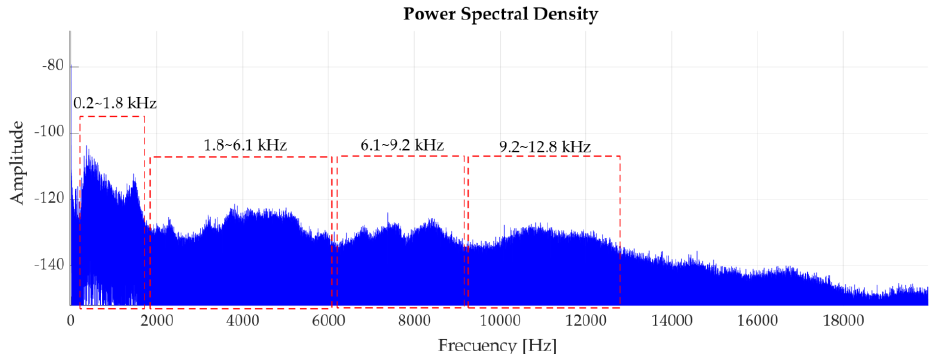
Figure 13. Power spectral density of the record 15 (40 kHz, rolling element failure, fail level 1, regime the 500 rpm). Proposed bands for envelope analysis.